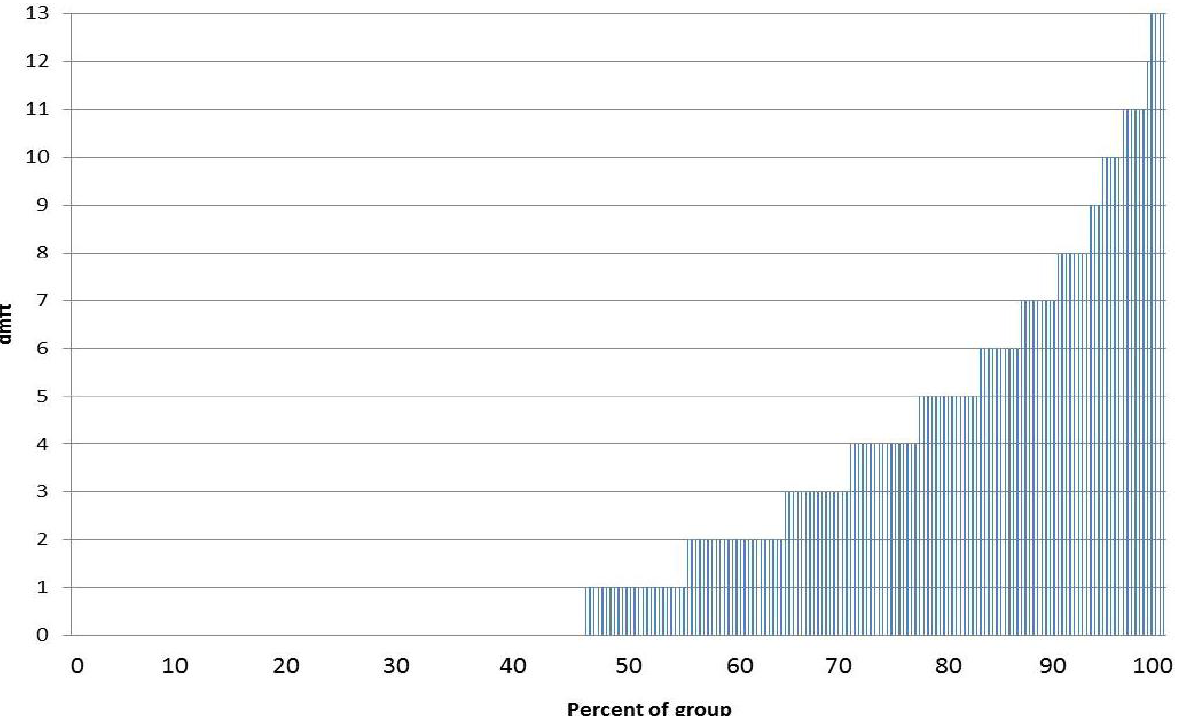
Figure 1. The cumulative distribution frequency of dental caries in this study population; 46.8% had no caries experience (decayed, missing, filled teeth =